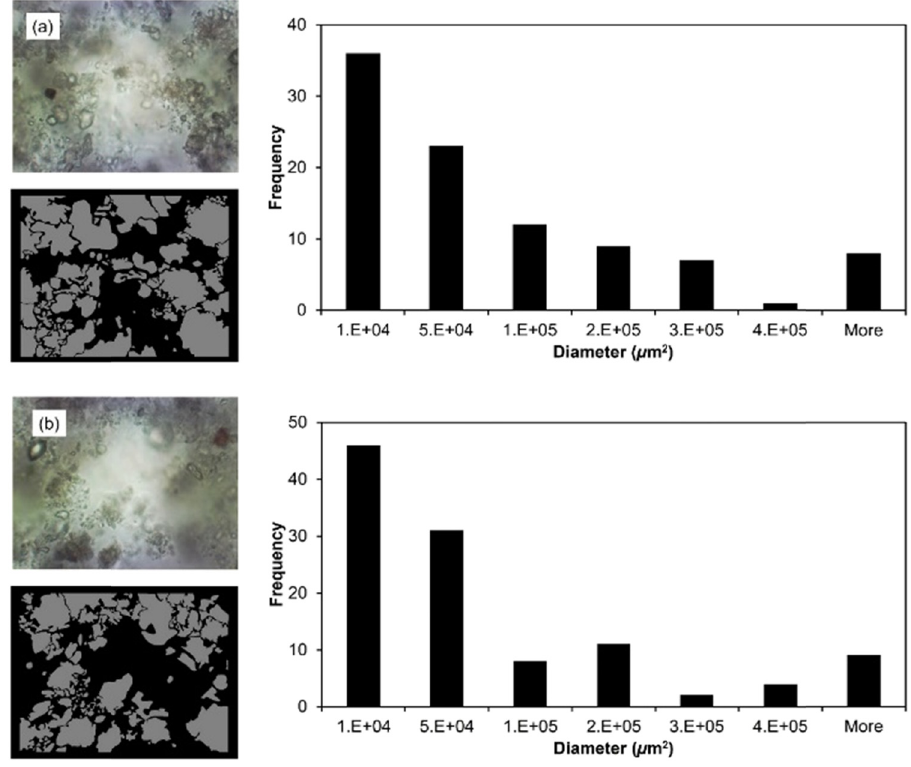
Figure 7: E ff ect of pH on fl oc formation in the coagulation process by L. leucocephala . Floc diameter was captured by photo microscope and analysis with free ImageJ software. Distribution of fl oc diameter without pH control ( a ) and with pH 5 ( b )